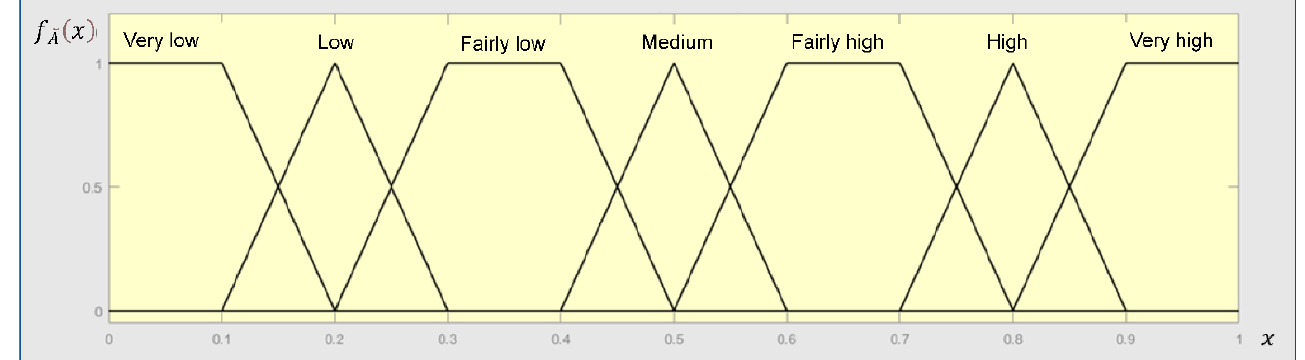
Table 4. The weighting criteria of experts.